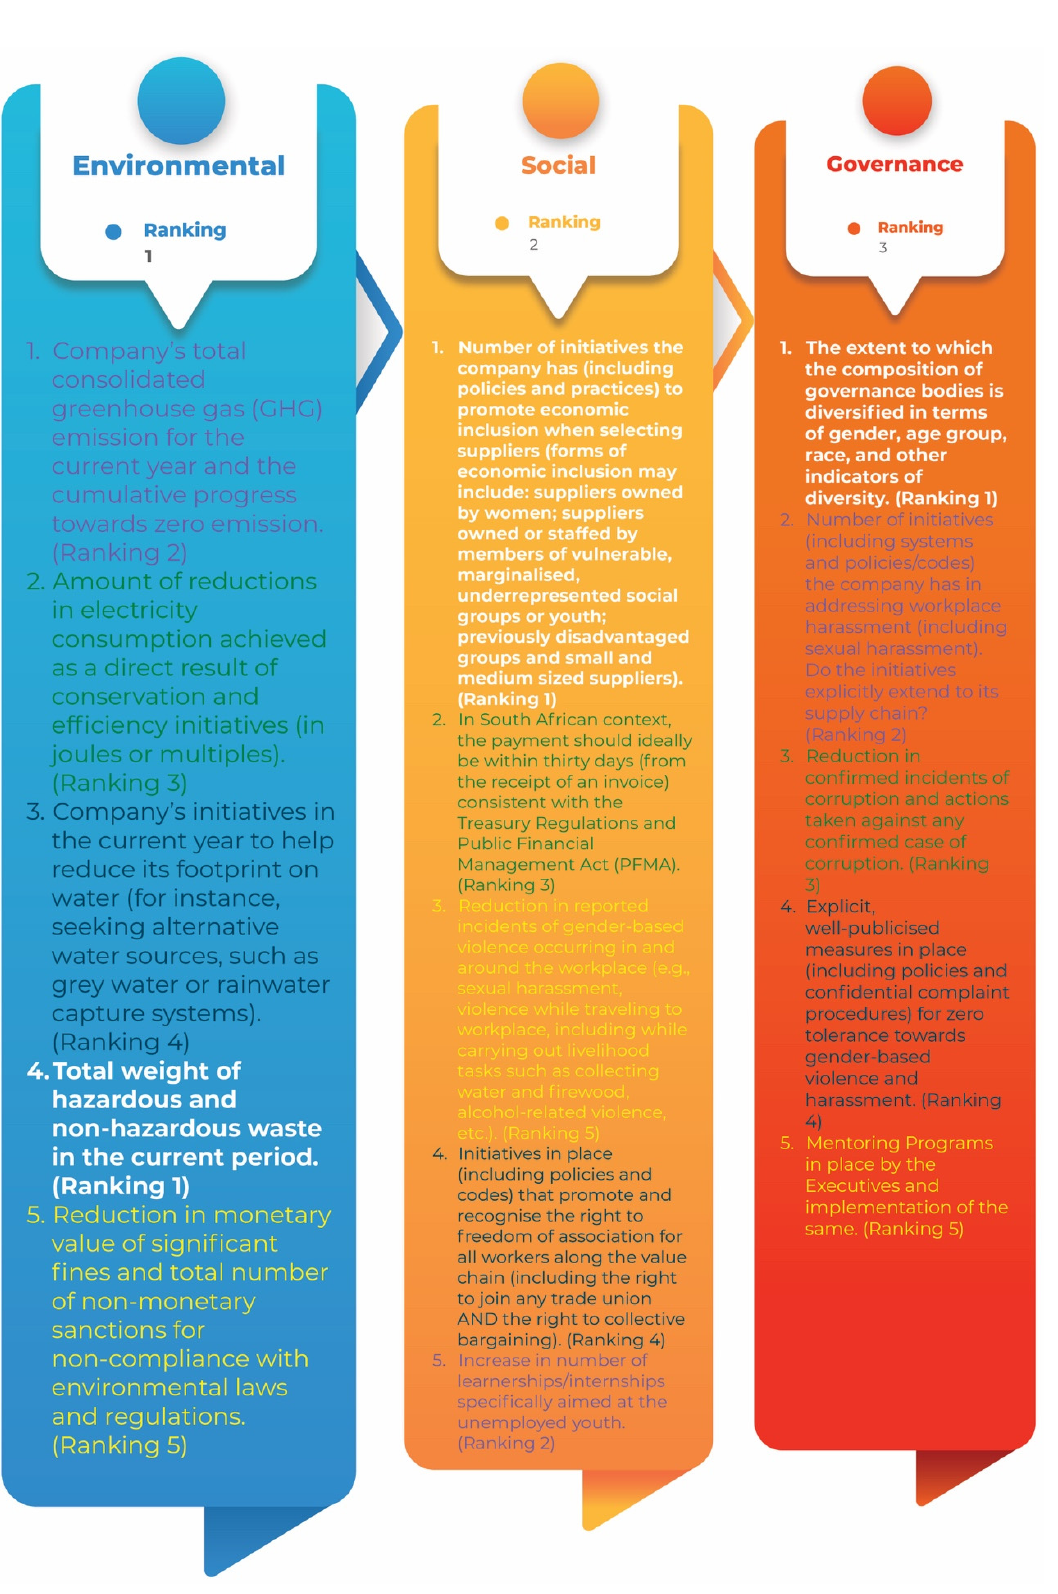
Figure 6. A framework for the prioritisation of ESG pillars and indicators for designing executive compensation plans. Source: Own